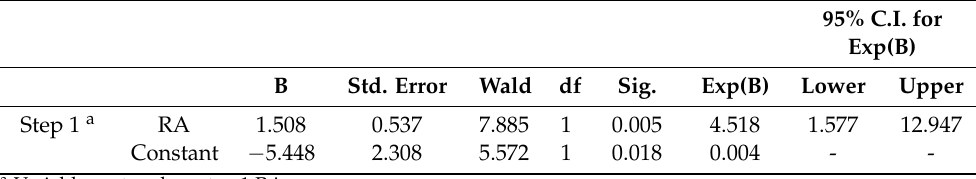
Table 12. Relative advantage: regression analysis for